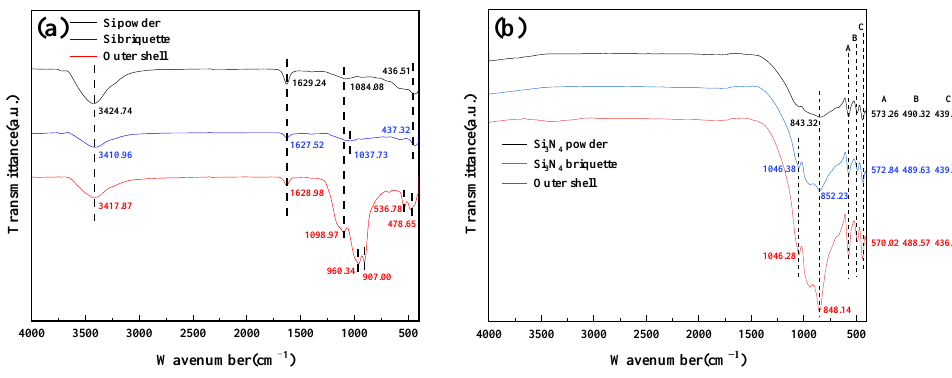
Figure 8. FTIR spectra of powder, briquette, and outer shell ( a ) Si and ( b ) Si 3 N 4 .